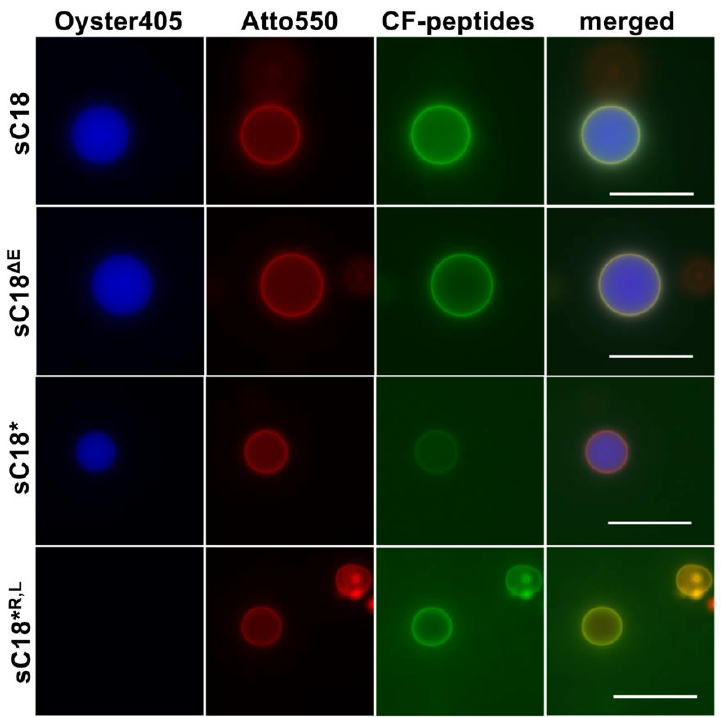
Figure 4. Peptide interaction with giant lamellar vesicles (GUVs) composed of DOPC/DOPE/DOPG (40:30:30); 1 µM solutions of sC18 variants were incubated with GUVs for 30 min and inspected using a fluorescence microscope (Keyence). Red: Atto550; green: CF-labeled peptides, blue: Oyster 405. Scale bar: 50 µm.